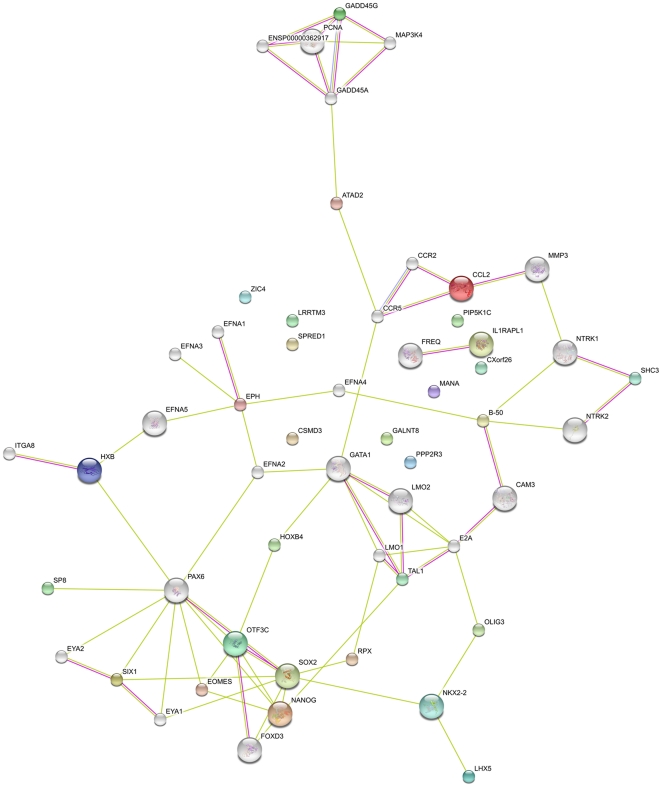
A gene regulatory network based on the 31 genes common in OCT4 ChIP-on-Chip targets derived from NCCIT, NTERA2 and H9 cells.GADD45G was also included in this analysis. The network was generated using the web-based program STRINGS [27]). Pink lines: connectivity based on experimental evidence. Green lines: connectivity based on text mining.